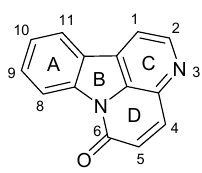
Figure 1. Structure of